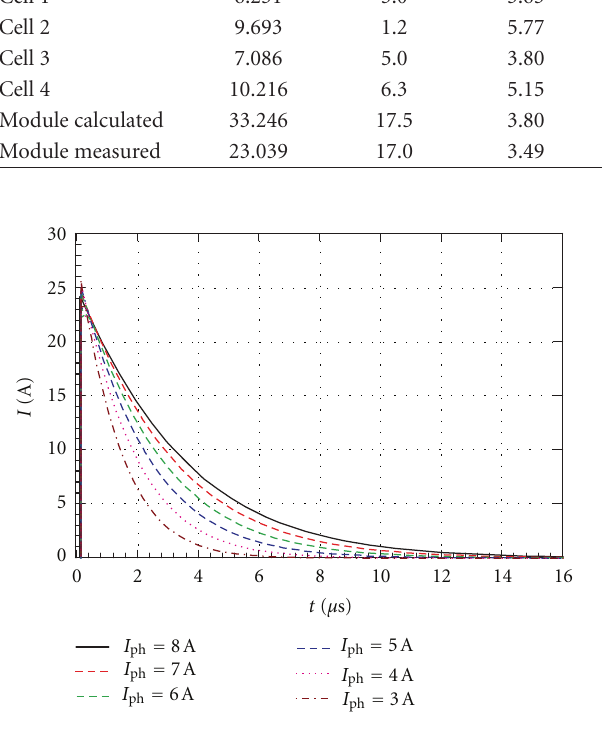
Figure 11: Simulated step response of mc-Si solar cell. Figure 12: E